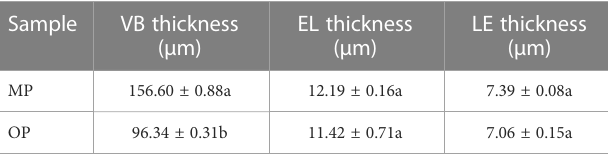
TABLE 2 Leaf anatomical characters of the mutant (MP) and wild type (OP). Sample